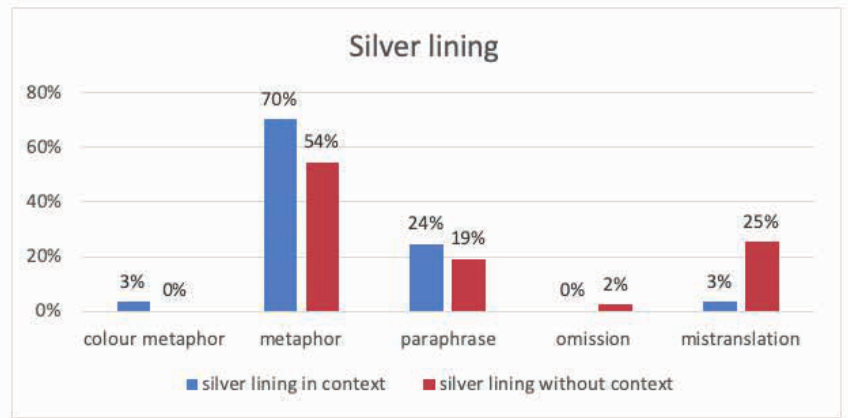
Figure 5: Translation strategies used for translating the colour metaphor red tape in context and without context.